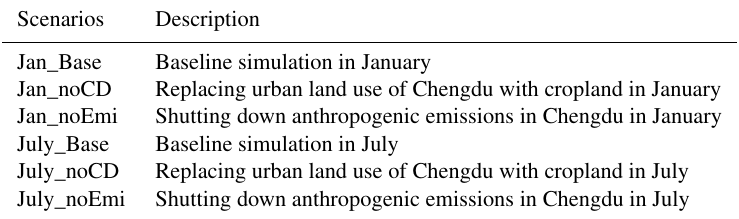
Table 2. Six numerical simulations are conducted in this